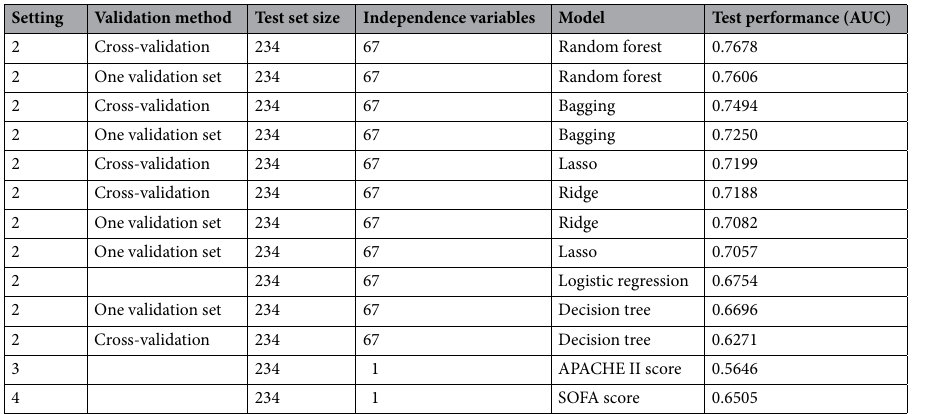
Figure 6. Comparison of the change in body weight estimates between the dialysis dependent group and non-dialysis dependent groups. ( A ) Univariate and ( B ) multivariate mixed-effect linear regression analyses are shown. The mixed-effects linear regression analysis between the two groups included the association with volume status at CRRT initiation, adjusted for age, sex, age-modified CCI, DM, hypertension, SOFA score, urine output for 6 h, and serum albumin level, MDRD, and eGFR at CRRT initiation.